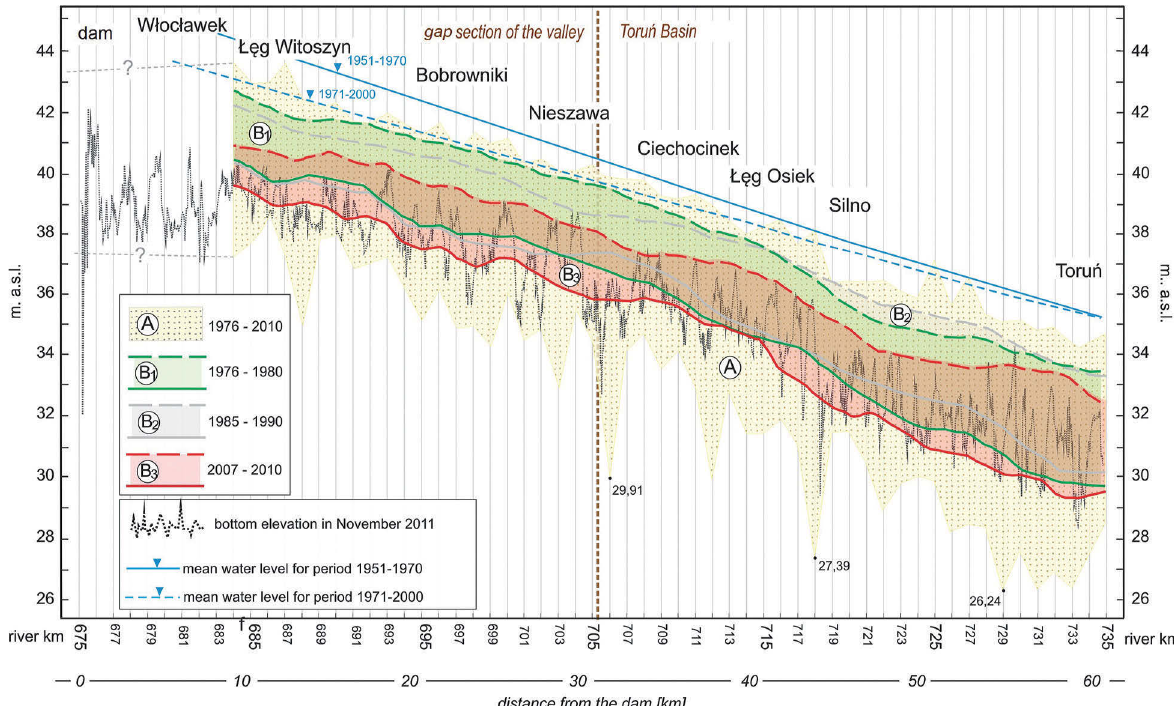
Fig. 5. Thickness diversity of alluvia (A) and the dynamics of sediment transformations (B) caused by the waters of the Vistula at the Włocławek–Toruń reach. Moving average of bottom elevation, measured in various periods at intervals of one kilometre of the river course at the deepest (continuous line) and shallowest point (dashed